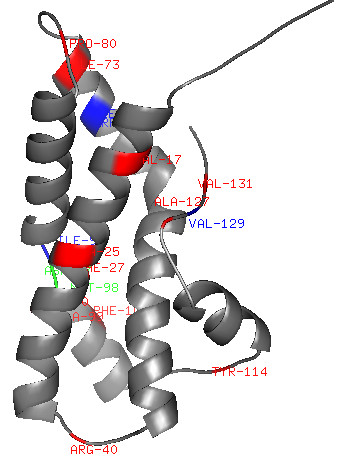
Lysin crystal structure from the red abalone Haliotis rufescens ([24], PDB ID 1ILS). Sites in color are in the (ω≤1, γ≥1) category. Sites that are blue (68,69,96,129) are from the volume and charge partitions. Sites that are red (17,5,27,30,40,73,80,99,101,114,127,131) are from the volume partition only. Finally, sites that are green (97–98) are from the charge partition only.